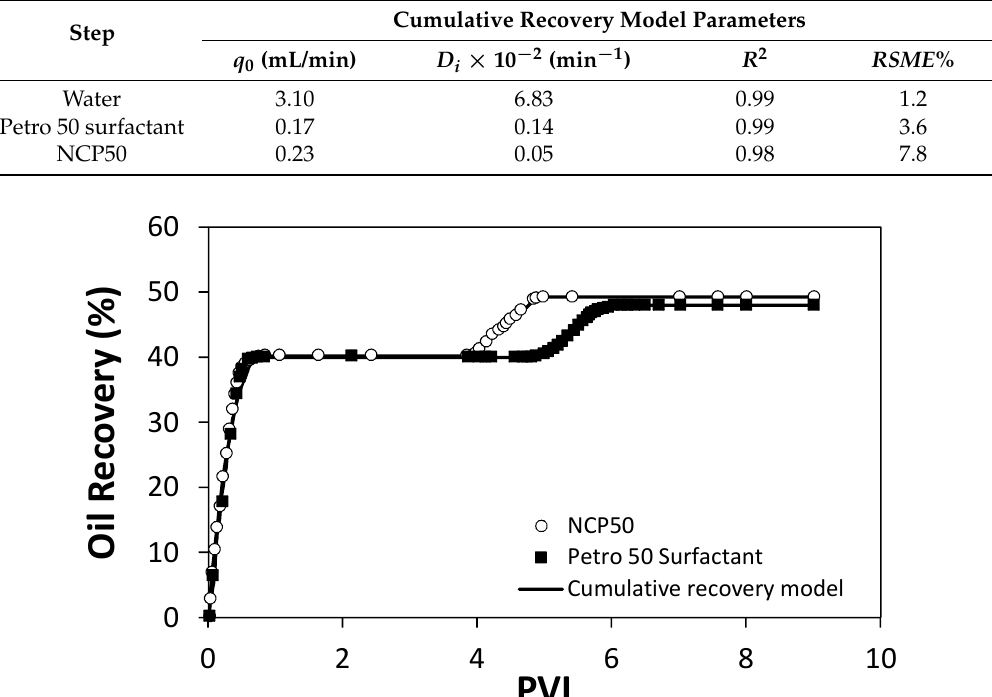
Figure 10. Oil recovery in a quarter five-spot pattern micromodel for the injection of water, followed by aqueous solutions of 10 mg/L of dissolved Petro 50 surfactant, or 10 mg/L of NCP50 material. Tests were conducted at 25 °C and atmospheric pressure.